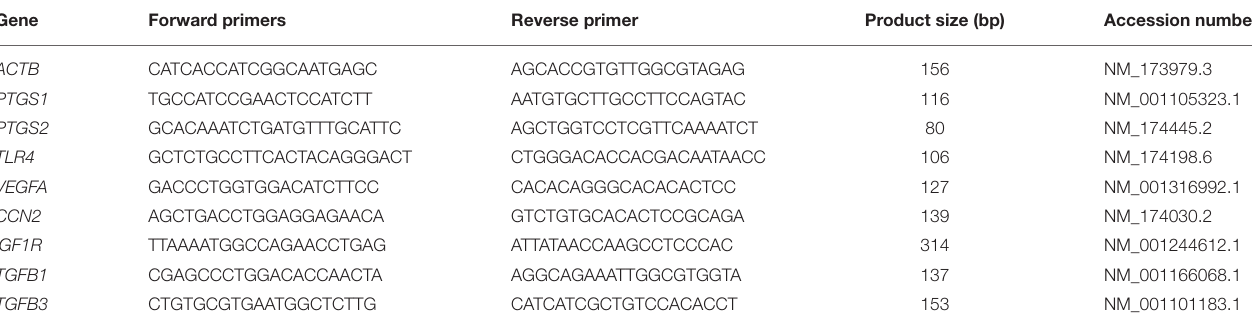
TABLE 1 | The list of primer